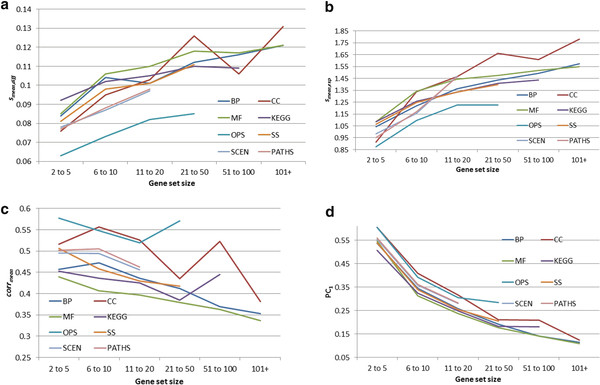
Gene set consistency by gene set size across the eight gene set sources.a. Assessing gene set consistency using smean,diff1. 1 Smaller values of smean,exp indicate more consistent sources. b. Assessing gene set consistency using smean,exp1. 1 Smaller values of smean,diff indicate more consistent sources. c. Assessing gene set consistency using corrmean1. 1Larger values of corrmean indicate more consistent sources.1d. Assessing gene set consistency using PC11. 1 Larger values of PC1 indicate more consistent sources